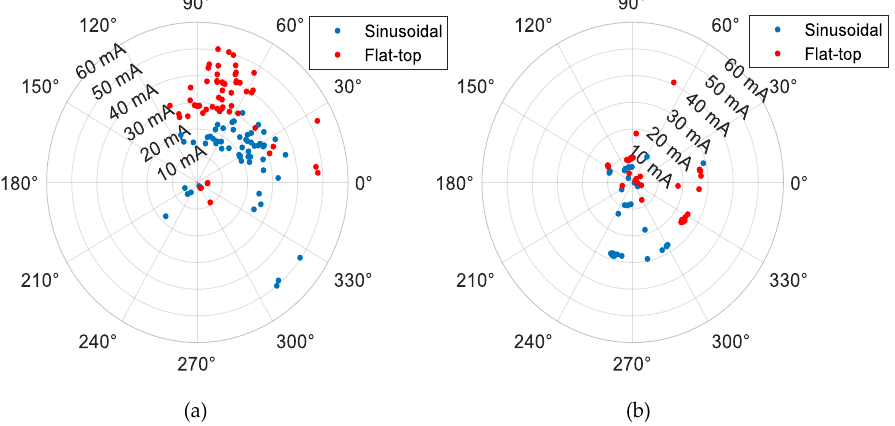
Figure A4. Seventh harmonic current emission of the selected lamps under the two types of supply voltage: ( a ) CFL and ( b ) LED lamps.